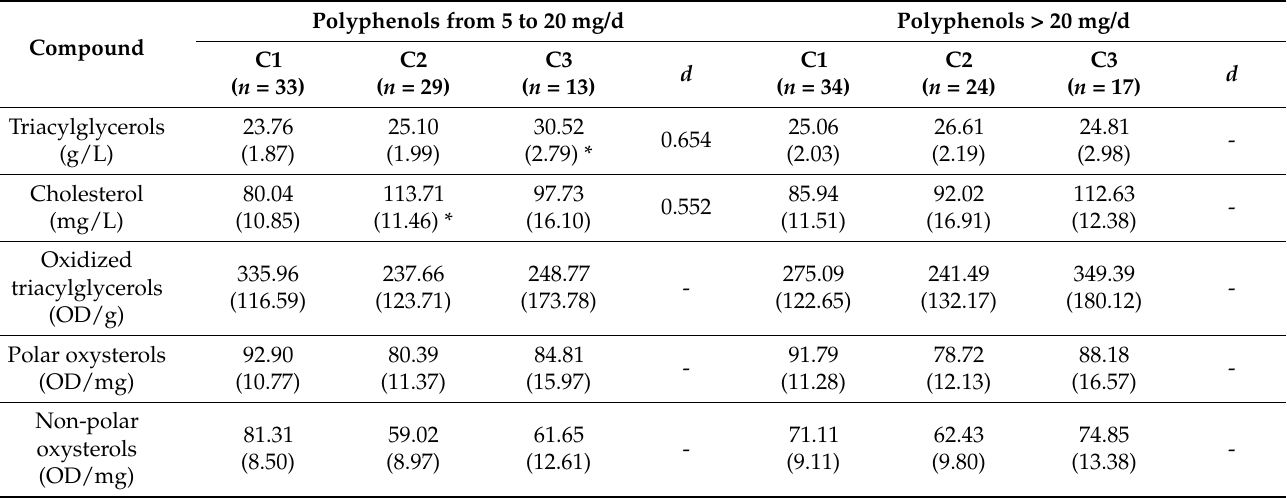
Table 5. Human milk lipids’ concentration according to polyphenolic clusters in postpartum women from C ó rdoba, Argentina ( n =